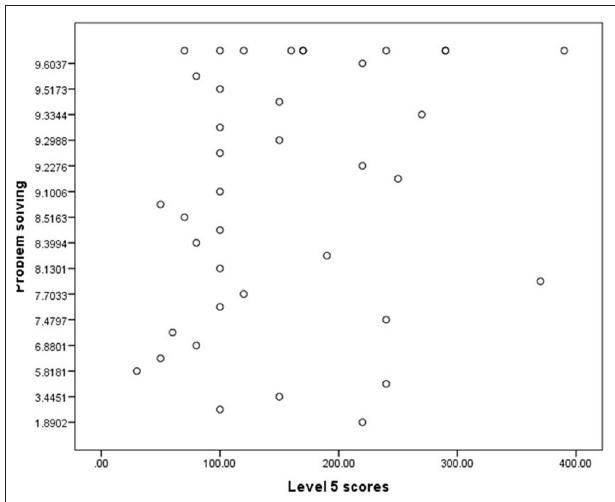
FIGURE 4 | Scatterplot for Level 5